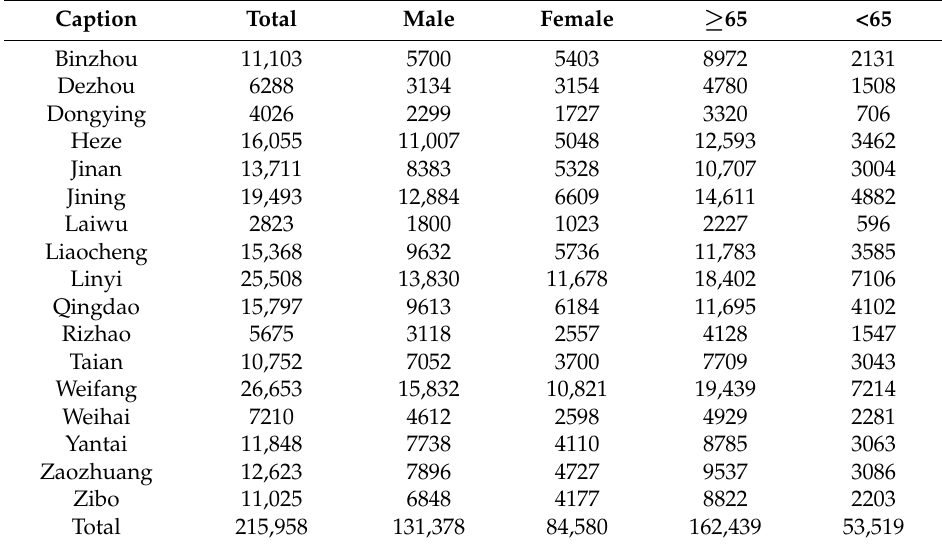
Table 1. Descriptive statistics of the daily hospital admissions grouped by sex and age in the 17 cities of the Shandong province (from 1 January 2015 to 31 December